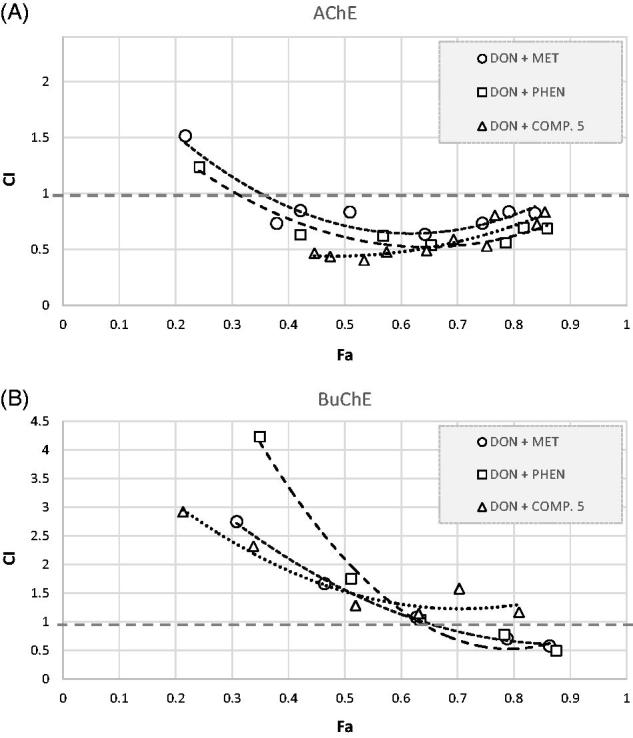
Analysis of potential synergism between donepezil and biguanides: metformin, phenformin, and compound 5 by the median effect principle. Data from the AChE (A) and BuChE (B) inhibitory activities assay were analysed by the Chou–Talalay method. The results are presented in a form of Fa-CI plots (Fa: Fraction affected; CI: Combination Index). The analysis proved that in the case of anti-AChE activity the lines of all examined binary mixtures fell in the section of synergism (CI < 1). The results regarding BuChE appear to be complex.